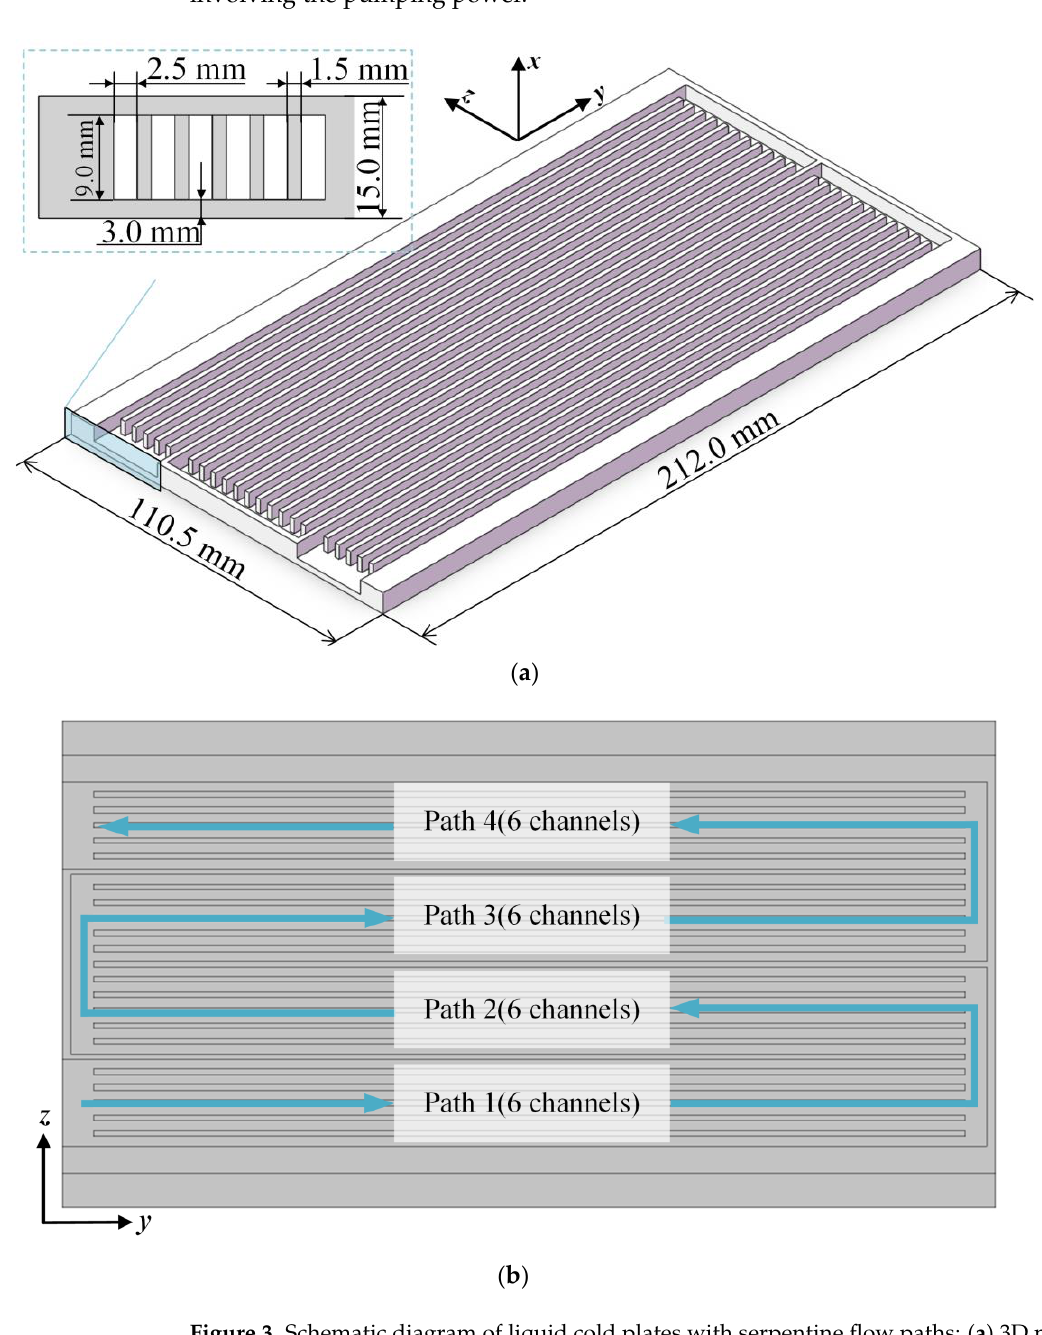
Figure 3. Schematic diagram of liquid cold plates with serpentine flow paths: ( a ) 3D model; ( b ) 2D model of flow paths.